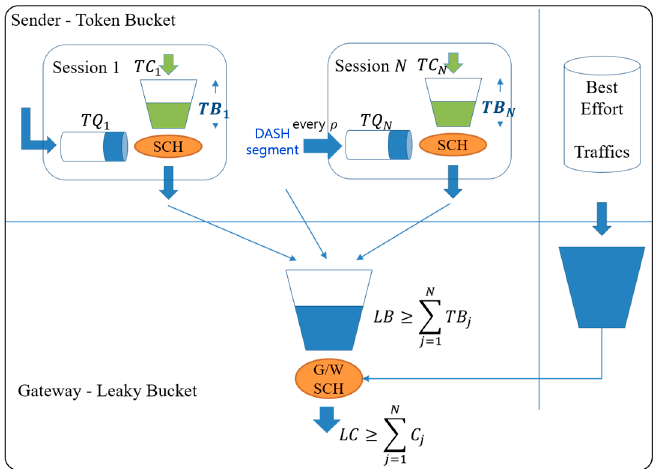
Figure 2. Proposal for the transmission structure for an internet protocol (IP)-based terrestrial digital broadcasting system. The token bucket can accommodate burst segment files, and the leaky bucket can be transmitted at a constant bit rate (CBR).